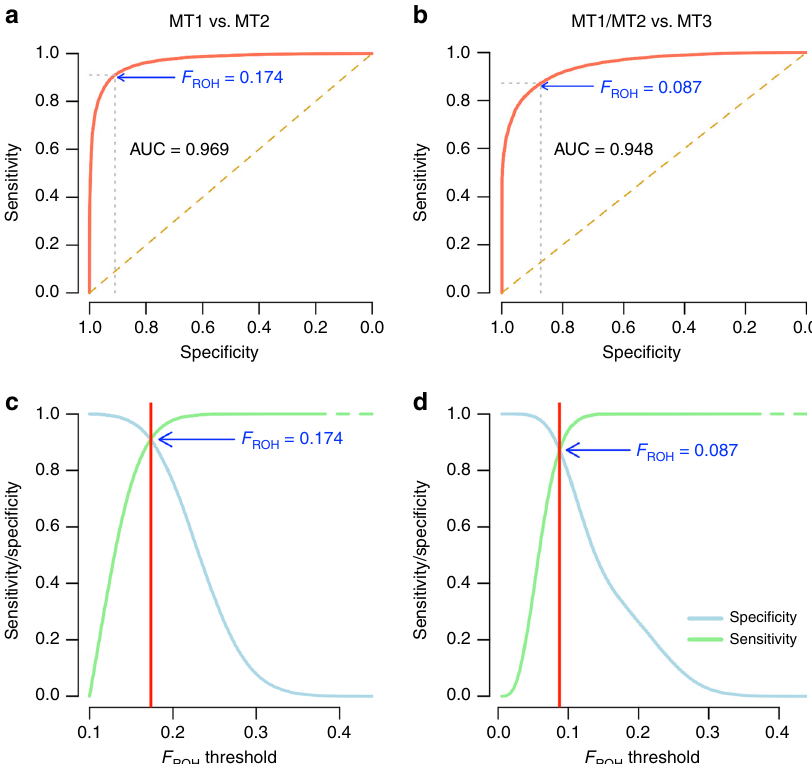
Fig. 1 Predictive performances of FROH to discriminate different types of inbreeding: mating type 1 (MT1: parent-offspring or fullsibs mating), mating type 2 (MT2: halfsibs, avuncular, grandparent-grandchild or double- fi rst cousins mating) or mating type 3 (MT3: fi rst-cousins mating). Panels a and c correspond to the comparison of MT1 and MT2, while panels b and d correspond to the comparison of MT1 and MT2 on the one hand and MT3 on the other hand. Predictive statistics assessed are the area under the receiver characteristics operating curve (AUC), the sensitivity to detect MT1 over MT2 (true positive rate) and speci fi city to distinguish MT1 from MT2 (true negative rate). FROH>0.17 yields a sensitivity and speci fi city >0.92 to discriminate MT1 from MT2; and FROH>0.087 yields a sensitivity of ~0.94 and a speci fi city of ~0.79 to discriminate MT1 or MT2 from MT3